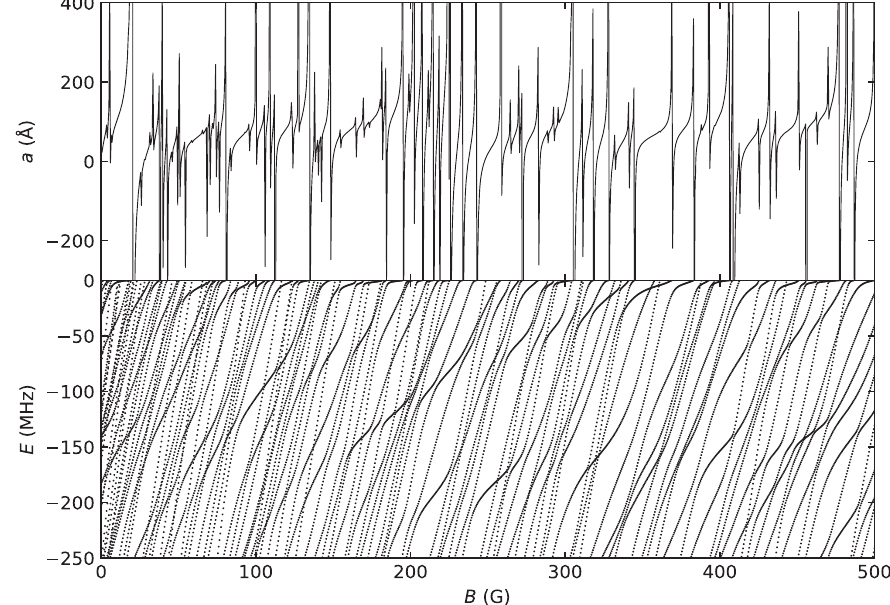
FIG. 2. Top: Scattering lengths as a function of the magnetic field for Dy þ Yb with short-range anisotropy as described in the text. Bottom: The corresponding near-threshold bound